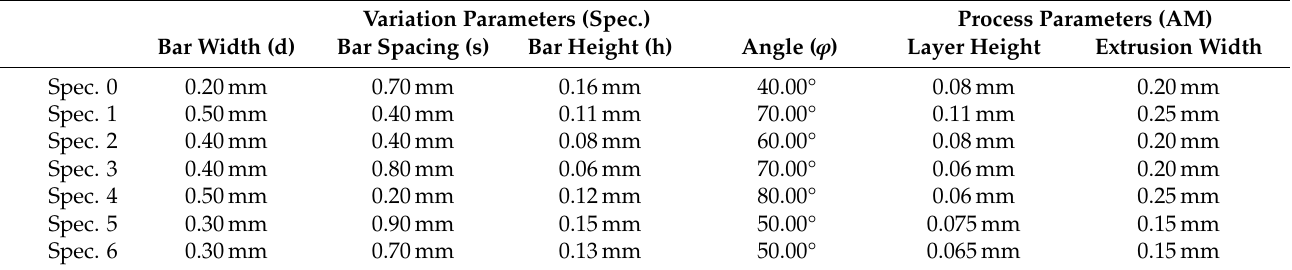
Table A1. Overview of the generated test Spec.s. The design parameters ( d , s , h , ϕ ) were varied using a Latin hypercube sampling. The process parameters (layer height, the extrusion width) are used during the manufacturing process and are given here for information